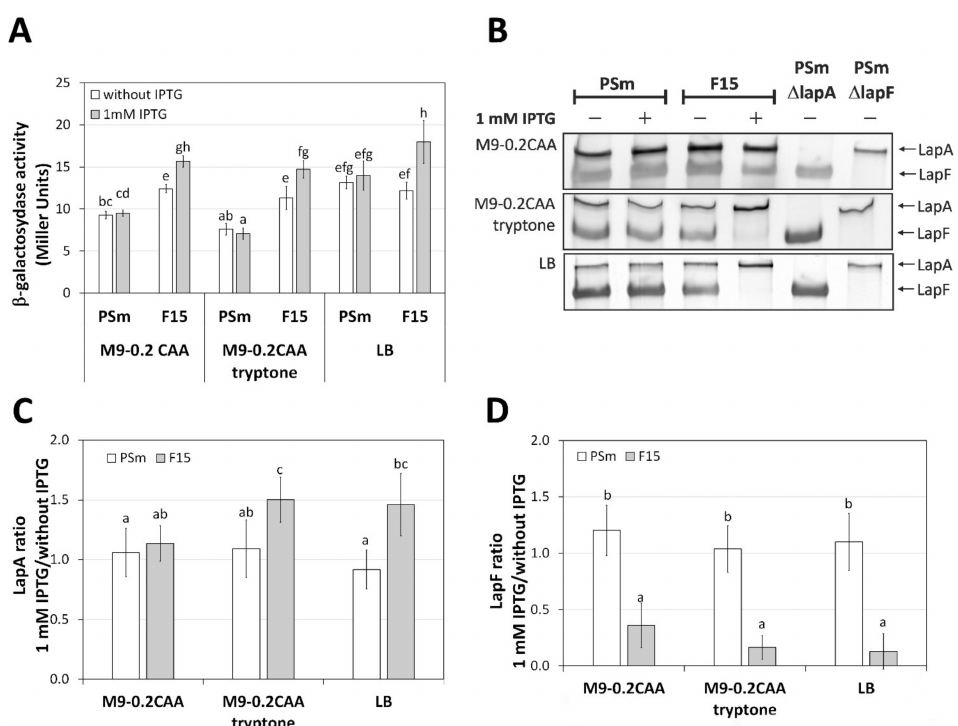
Figure 3. The expression of adhesins LapA and LapF in P. putida strains PSm and F15. ( A ) β - galactosidase activity in cells carrying pB_P lapA 1-8 where lapA promoter region cloned in front of lacZ gene. Arithmetical means of at least three independent sets of measurements and 95% confidence intervals of the arithmetic mean. The homogenous groups are shown above columns by lower-case letters. Identical letters denote nonsignificant differences ( p ≥ 0.05) among averages of means. ( B ) SDS-PAA gel electrophoresis from cell lysates prepared from cells grown in M9-0.2CAA, M9-0.2CAA+tryptone or LB medium with or without IPTG. PSm ∆ lapA and PSm ∆ lapF cell lysates were loaded onto the gel as negative controls of LapA and LapF. The arrows indicate the location of LapA and LapF. 40 mg of total protein was applied to the line. ( C ) Normalised LapA and ( D ) LapF amount. The amount of adhesine determined from the crude lysate of cells grown with IPTG was divided by the amount of LapA determined from the crude lysate of cells grown without IPTG. The averages of at least 6 biological parallels are given, with 95% confidence intervals. The homogenous groups are shown above columns by lower-case letters. Identical letters denote nonsignificant differences ( p ≥ 0.05) between the averages of the